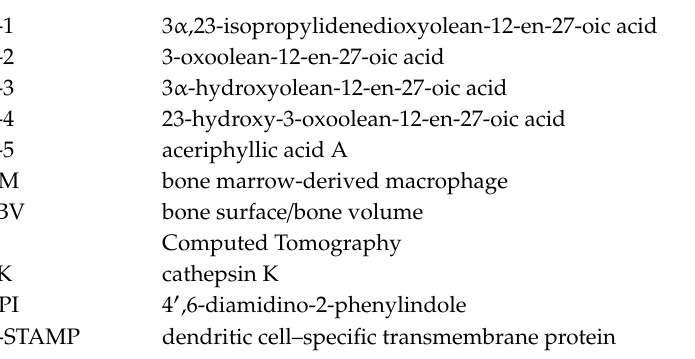
Figure S1: E ff ect of quercetin on RANKL-induced osteoclast